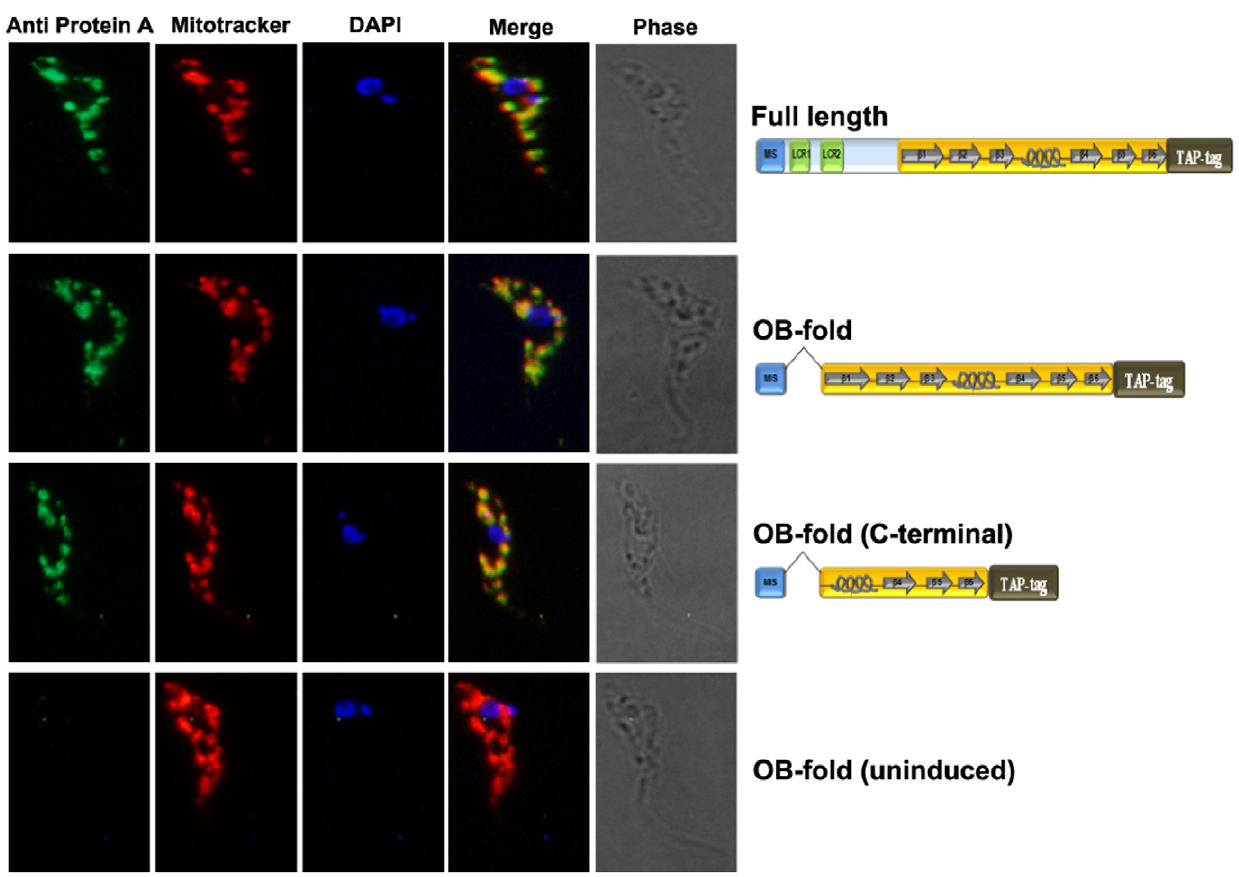
Figure 3. Mitochondrial localization of TAP-tagged full length and truncated KREPA4 proteins. TAP-tagged full length and truncated KREPA4 proteins were detected in the mitochondria as revealed by co-localization with anti protein-A antibody and mitotracker stain. DAPI was used for staining of the nucleus and kinetoplast. An uninduced control, not expressing the TAP-tag did not show any staining with the anti-protein A antibody.